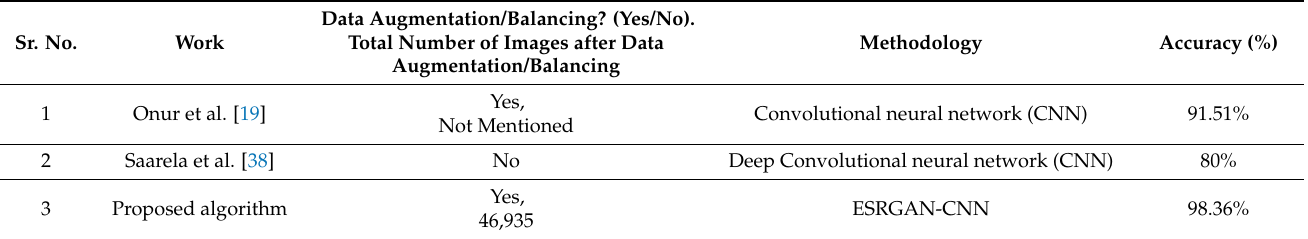
Table 10. Highest accuracy for protocol-II.